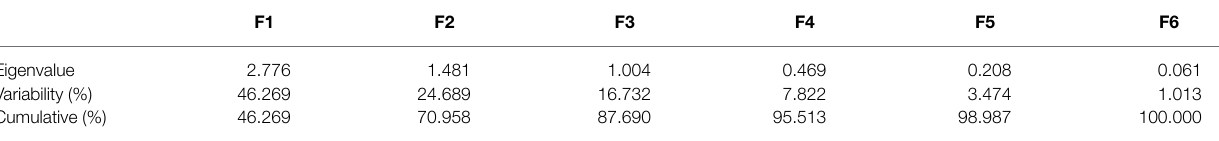
TABLE 2 | Principal component analysis of biochemical modulations in cotton under drought stress.